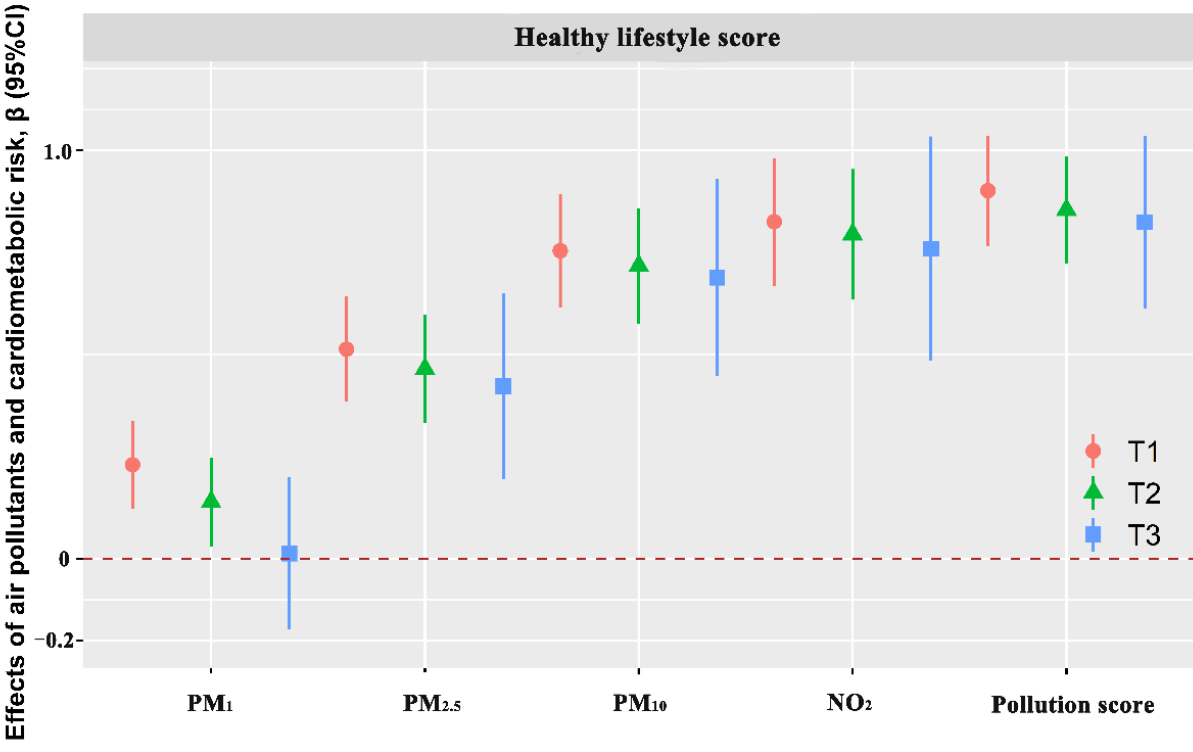
Figure 1. The associations of ambient air pollutants (per IQR increment) and the air pollution score (per IQR increment) with the cardiometabolic risk score by tertiles groups of healthy lifestyles. Abbreviations: PM 1 , particulate matter with an aerodynamics diameter of ≤ 1.0 µ m; PM 2.5 , particulate matter with an aerodynamics diameter of ≤ 2.5 μ m; PM 10 , particulate matter with an aerodynamics diameter of ≤ 10 μ m; NO 2 , nitrogen dioxide. Concentrations of long ‐ term exposure to four air pollu ‐ tants were reflected by three ‐ year averaged concentrations before the baseline of this study. The associations were adjusted for age, gender, marital status, educational level, personal averaged monthly income, family history of CHD, family history of stroke, family history of T2DM, and fam ‐ ily history of hypertension.